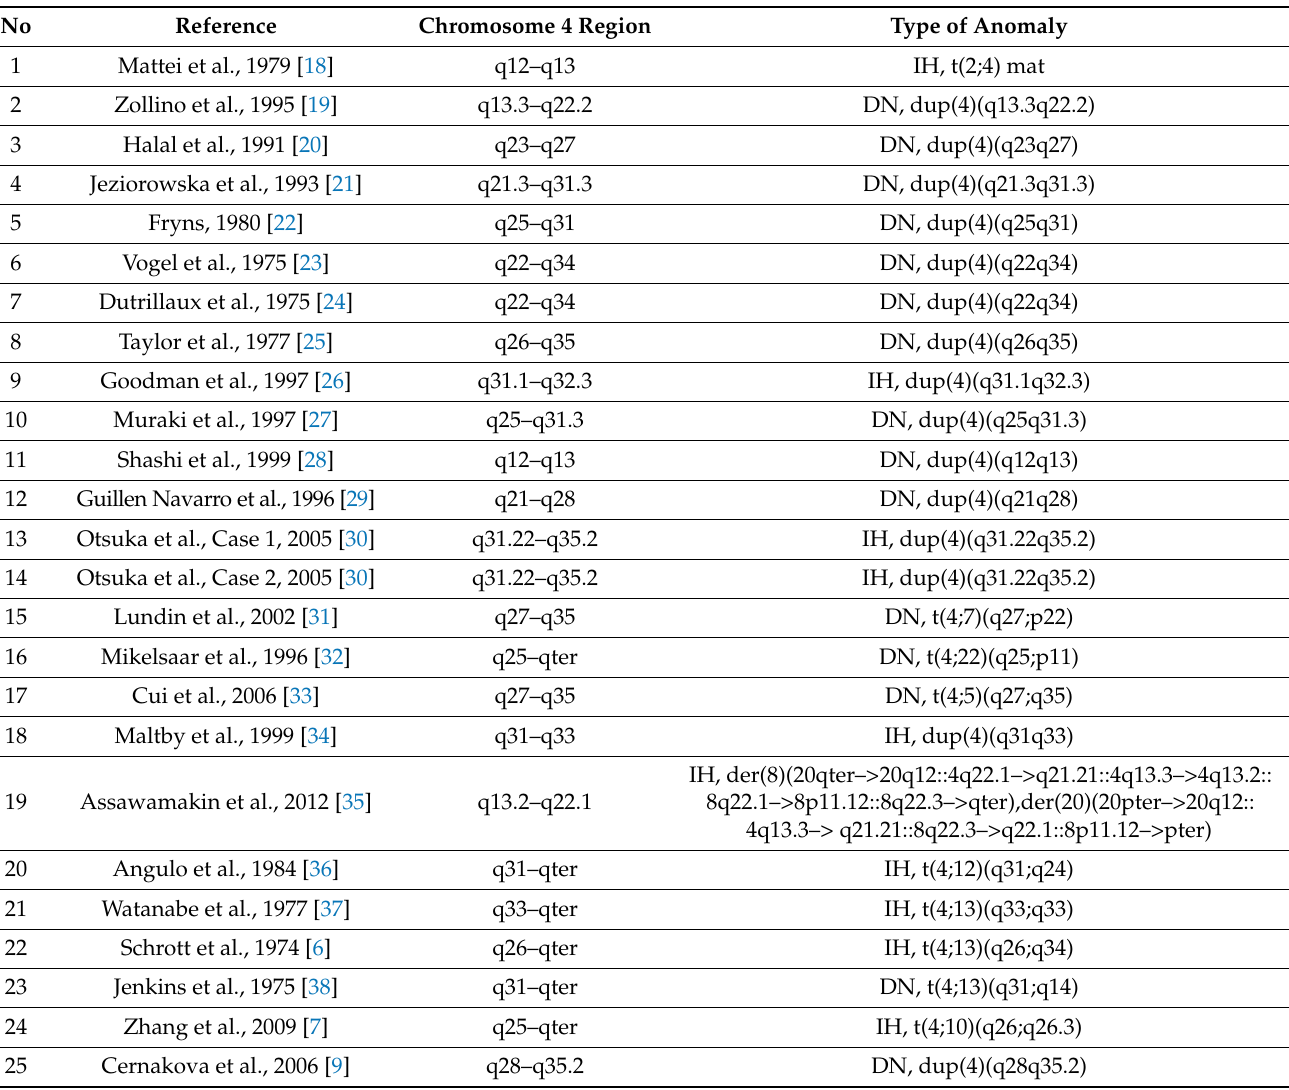
Figure 8. Ideogram of chromosome 4 and distribution of breakpoints in 4q partial trisomy. Red lines represent different 4q duplications identified by different authors; blue lines represent the cases with a translocation between chromosome 4 and other chromosomes; the numbers 1–50 represent the references presented in Table 1. Table 1. Different types of 4q partial trisomy.